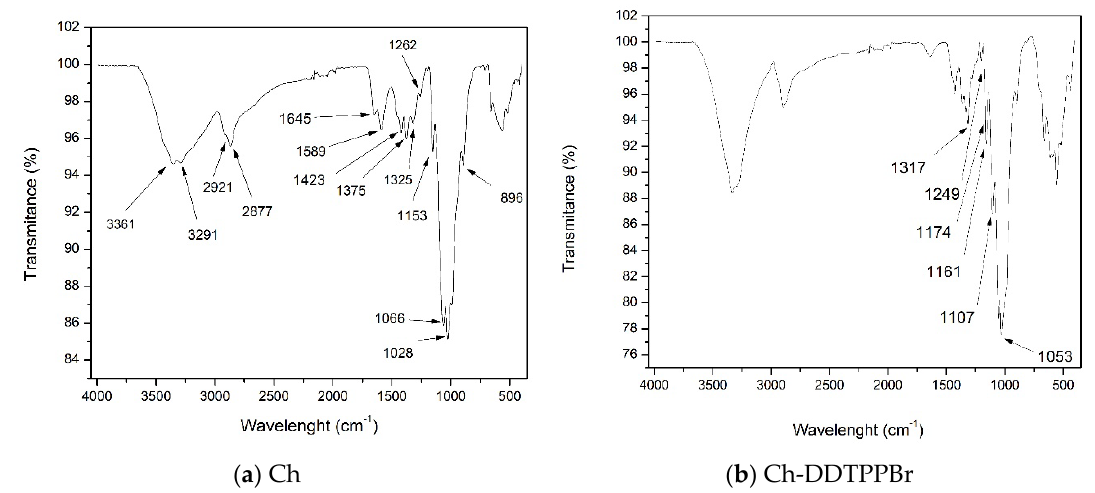
Figure 3. Fourier-transform infrared spectroscopy, FT-IR for the materials: ( a ) Ch and ( b ) Ch- DDTPPBr.